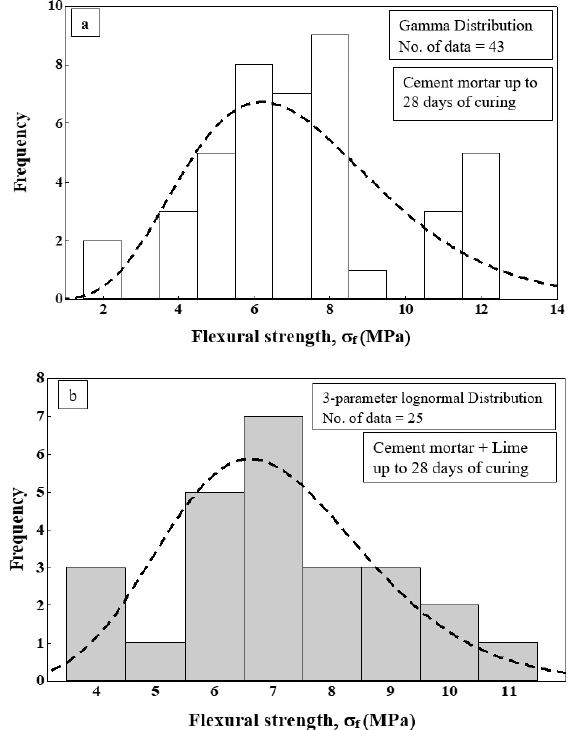
Figure 7: Statistical distribution of the flexural strength for (a) ce- ment mortar and (b) cement mortar modified with lime up to 28 days of